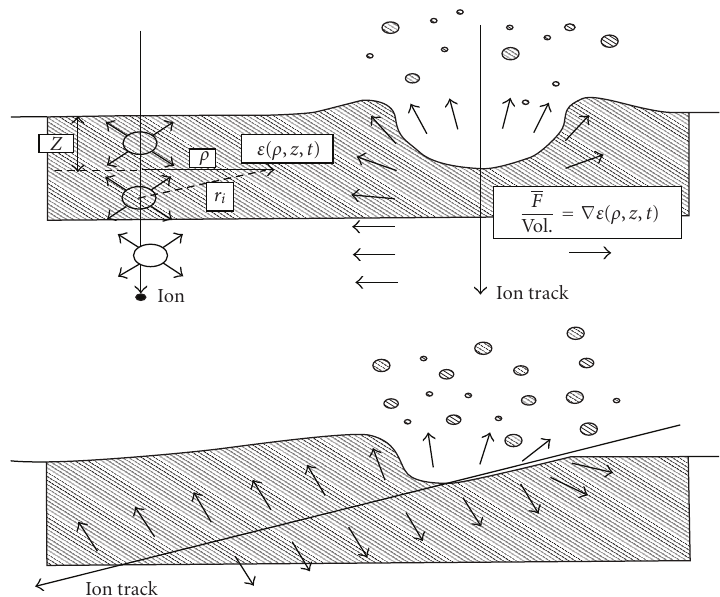
Figure 53: Schematic diagram of models of sputtering and plastic deformation due to a cylindrical pressure pulse.